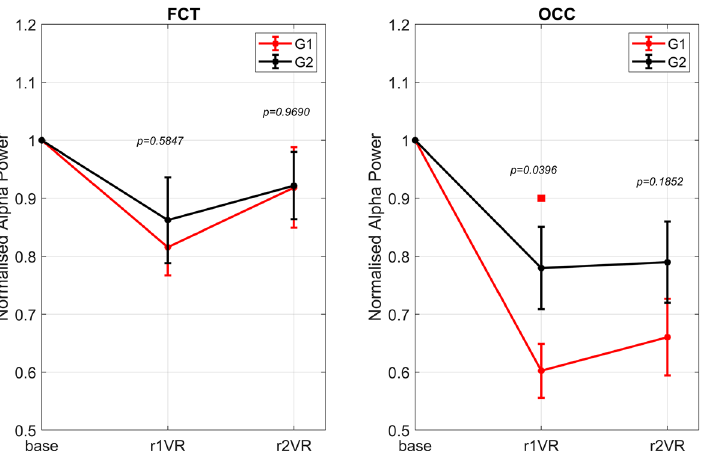
Figure 5. Regional-wise analysis in group G1 and G2: normalized alpha power during each of the three phases ( base , r1VR , and r2VR ), averaged across participants of the same group (mean ± sem), over the two scalp macro- regions (fronto-central-temporal FCT (left panel); parieto-occipital OCC (right panel)). Red square denotes statistical significance difference between the two groups (one-tailed permutation-based t test, p-value < 0.05 Bonferroni-corrected for multiple comparisons). The only significant difference between groups G1 and G2 is achieved in r1VR phase and over the OCC scalp region (corrected p-value =